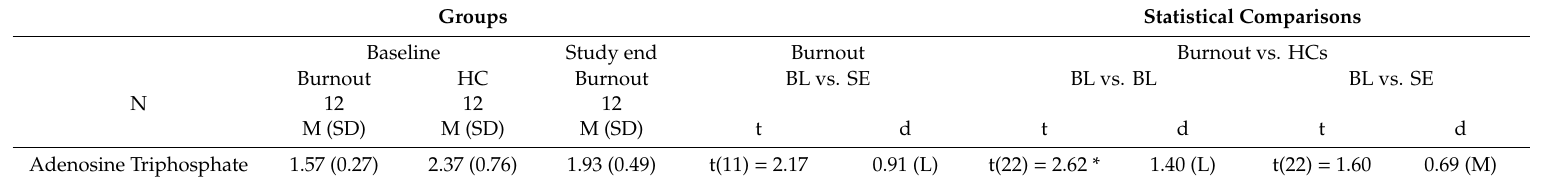
Table 2. Descriptive and statistical indices of adenosine trisphosphate (ATP) concentrations in individuals with and without burnout; baseline and study end. Groups Statistical Comparisons Baseline Study end Burnout vs.